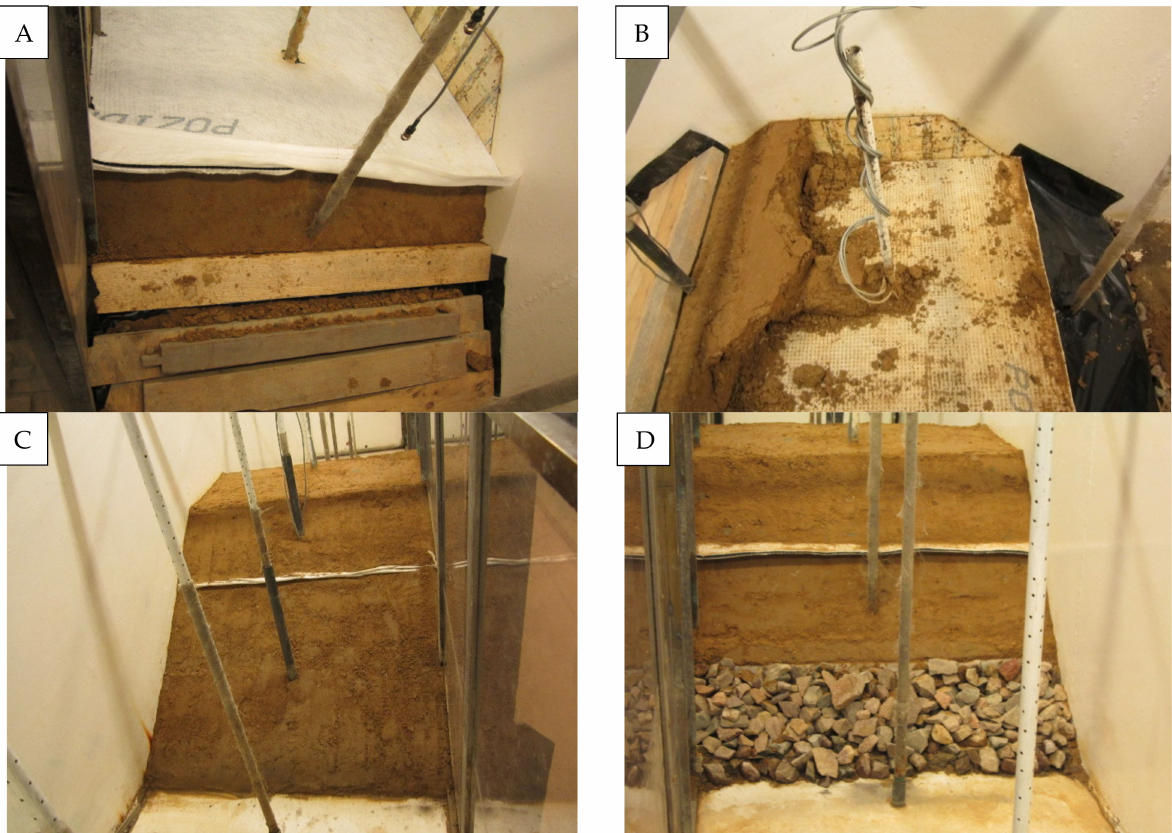
Figure 3. View of the model embankment with embedded geosynthetic; ( A , B ) embankment composition: ( A ) laying of geosynthetic and slope profiling; ( B ) covering of geosynthetic with a layer of soil, forming an embankment crown, protecting slopes against scattering; ( C , D ) after embankment execution: ( C ) waterside slope; ( D ) landside